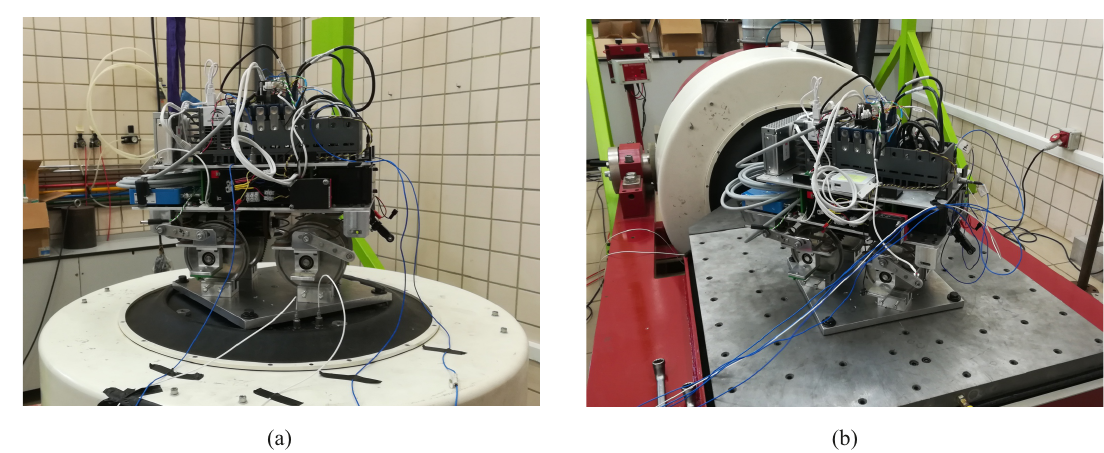
Figure 7. CAD of the instrumented scaled vehicle.